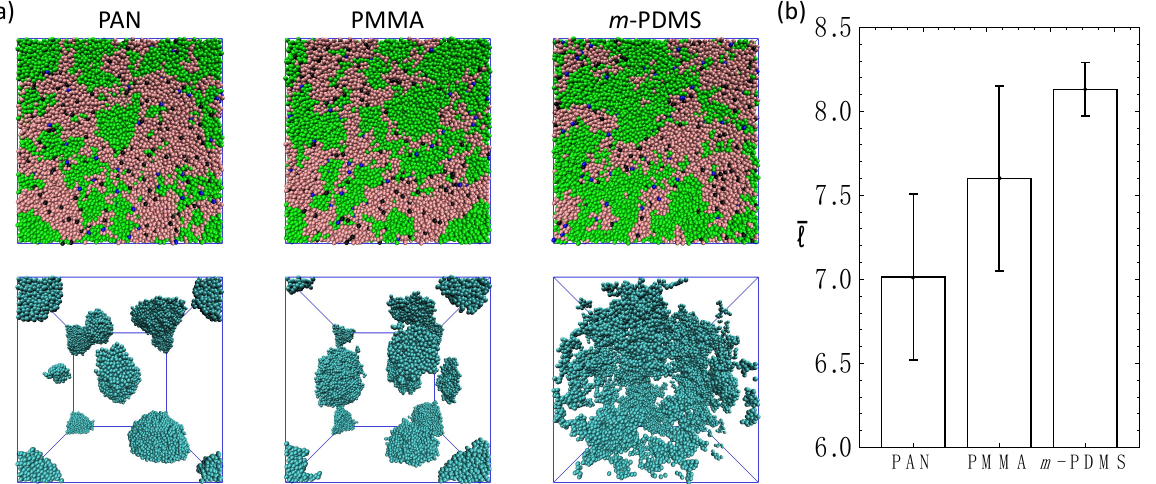
Figure 6. Ternary systems with f v − PDMS = 0.4, f PHMS = 0.5, N PHMS = 30, N v − PDMS = N X = 60, where X = PAN, PMMA, m -PDMS. ( a ) Simulation snapshots upon equilibration. All beads are shown in the top row (beads of both sacrificial components are in green); and only beads of the non-reactive component (X) are shown in the bottom row. ( b ) Equilibrium characteristic length scale, l.